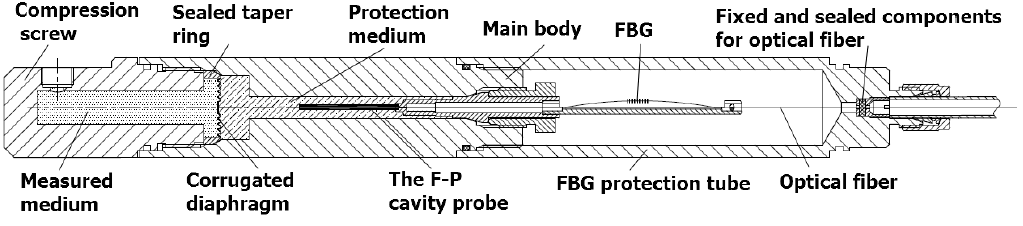
Figure 9. The structure diagram of optical fiber F-P cavity pressure sensor. (Reproduced from [21] ).